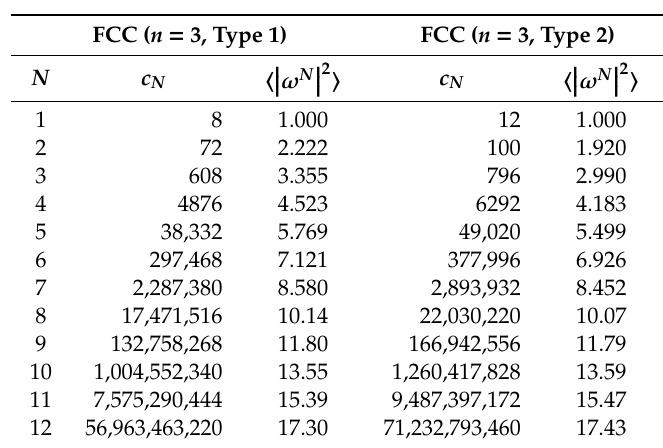
Table A10. Properties of SAWS on FCC lattice with 3 layers between the confining planes ( n = 3, Type 1, 2).